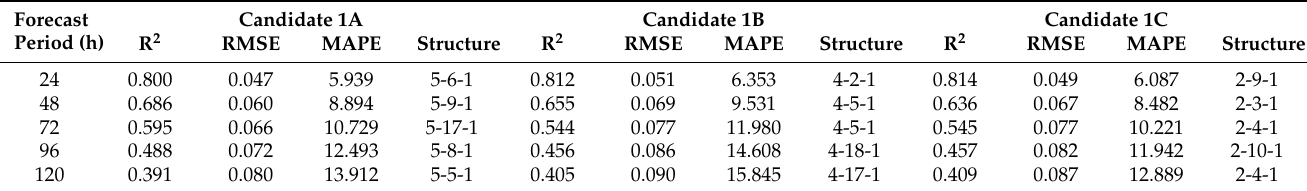
Table A2. The validation results of the single model fitted with ANN. Units of the RMSE and the MAPE were gram per litres and percent